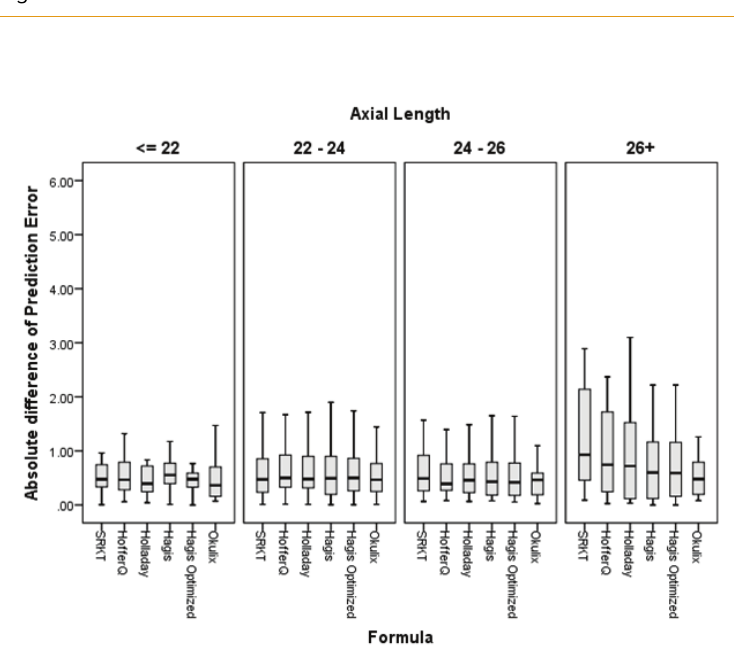
Figure 1. The absolute prediction error of each formula. Comparison of the prediction error of the formulas in subgroup analysis based on the AL using pairwise comparisons with the Bonferroni correction showed that the OKULIX had the lowest MAE compared to other formulas (all P <